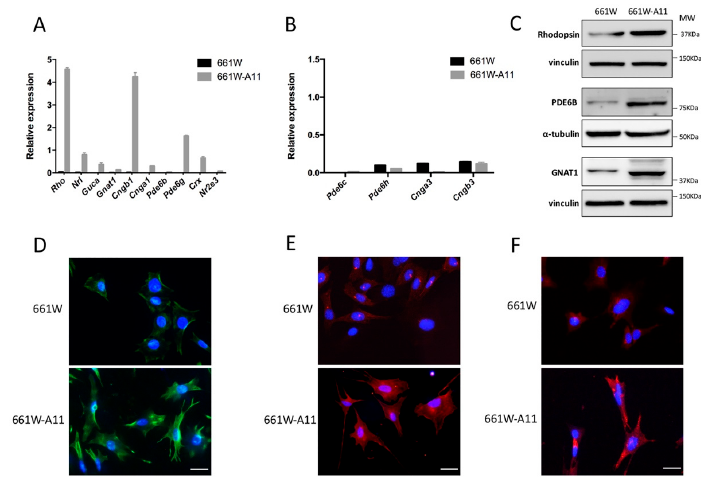
Figure 2. 661W-A11 cells express rod-specific genes and proteins. ( A ) Rod-specific mRNAs and ( B ) cone-specific mRNAs were analyzed by real-time qPCR. S26 was used as a reference gene. ( C ) Immunobloting of rhodopsin, PDE6B and GNAT1 on 661W and 661W-A11 cells. Normalization with vinculin for rhodopsin and GNAT1 and with α -tubulin for PDE6B is shown below each analyzed protein. ( D ) Immunofluorescence analysis of rhodopsin (green) protein on 661W and 661W- A11 cells. ( E ) Immunofluorescence analysis of PDE6B (red) protein on 661W and 661W-A11 cells. ( F ) Immunofluorescence analysis of GNAT1 (red) protein on 661W and 661W-A11 cells. Nuclei were stained with 4 ′ ,6-diamidino-2-phenylindole (DAPI): blue. Scale bar: 10 μ m.